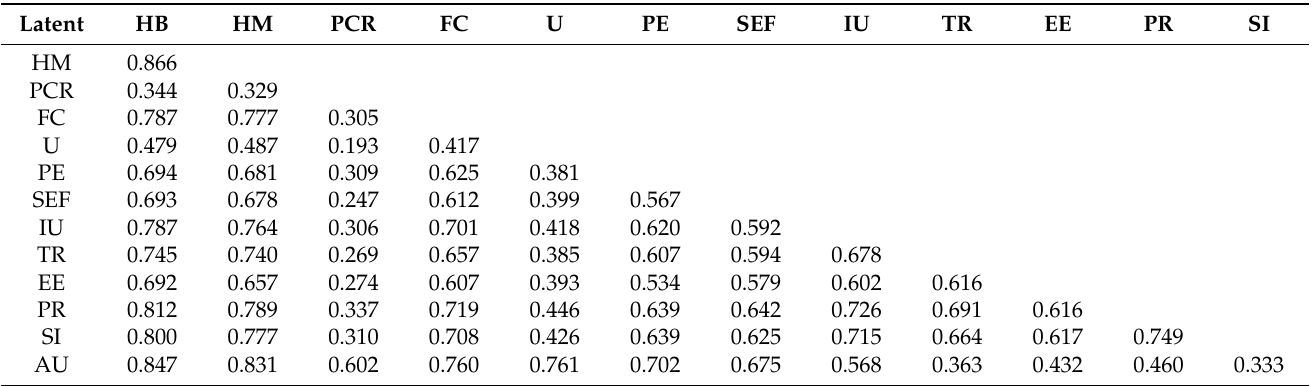
Table 4. Pearson’s R